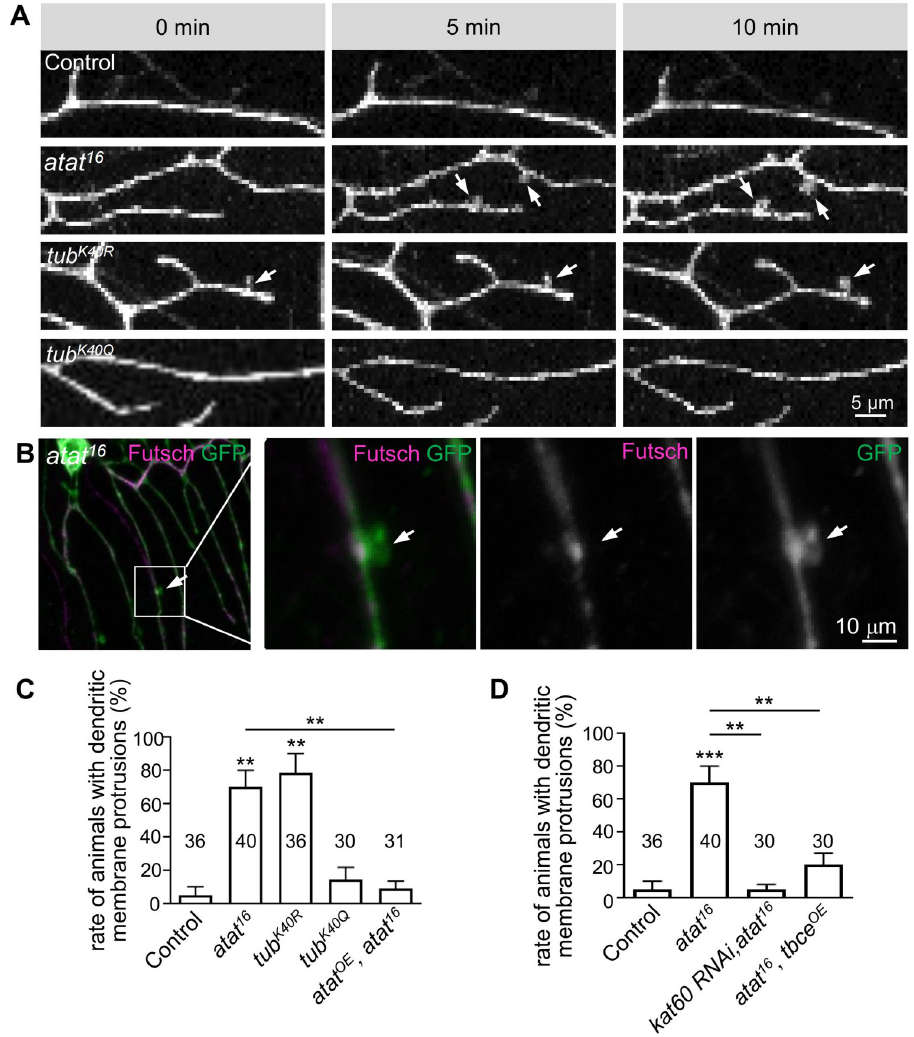
Fig 6. Tubulin deacetylation increases dendritic membrane protrusion formation. (A) Live imaging of dendrites of class I da neurons using the membrane marker mCD8-GFP driven by 221-Gal4 to monitor membrane protrusion formations in second instar larvae of the control ( 221-Gal4 > mCD8-GFP), atat 16 , α 1-tubulin K40R ( tub K40R ), and α 1-tubulin K40Q ( tub K40Q ). Arrows denote the protrusions extending from the dendrites. Scale bar: 5 μ m. (B) Class I da neurons in second instar larvae of atat 16 were stained with anti-Futsch (magenta, labels stable microtubules) and GFP (green). The membrane protrusion (denoted by arrows) lacks Futsch signals. Scale bar: 10 μ m. (C and D) Quantification of the percentages of animals with dendritic membrane protrusions. Data were collected from 3~5 independent experiments and 7~15 animals were examined in each experiment. Mean ± SEM. One-way ANOVA with Tukey’s multiple comparisons test. ��� p < 0.001, � p < 0.05.